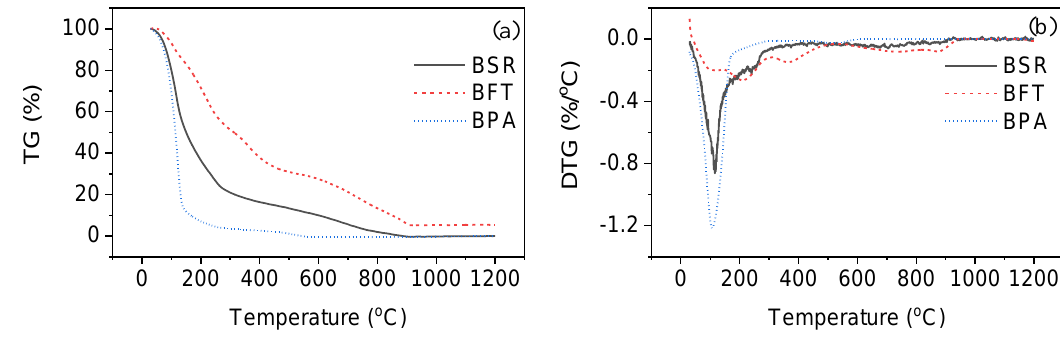
Figure 6. ( a ) TG curves of gasification of bio-oils; ( b ) DTG curves of gasification of bio-oils.